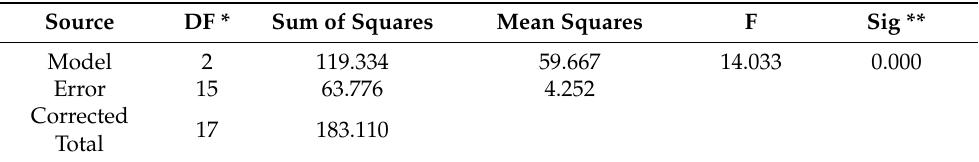
Table 3. ANOVA test results in examining the significance of LST difference between the studied land use classes (1987–2019).